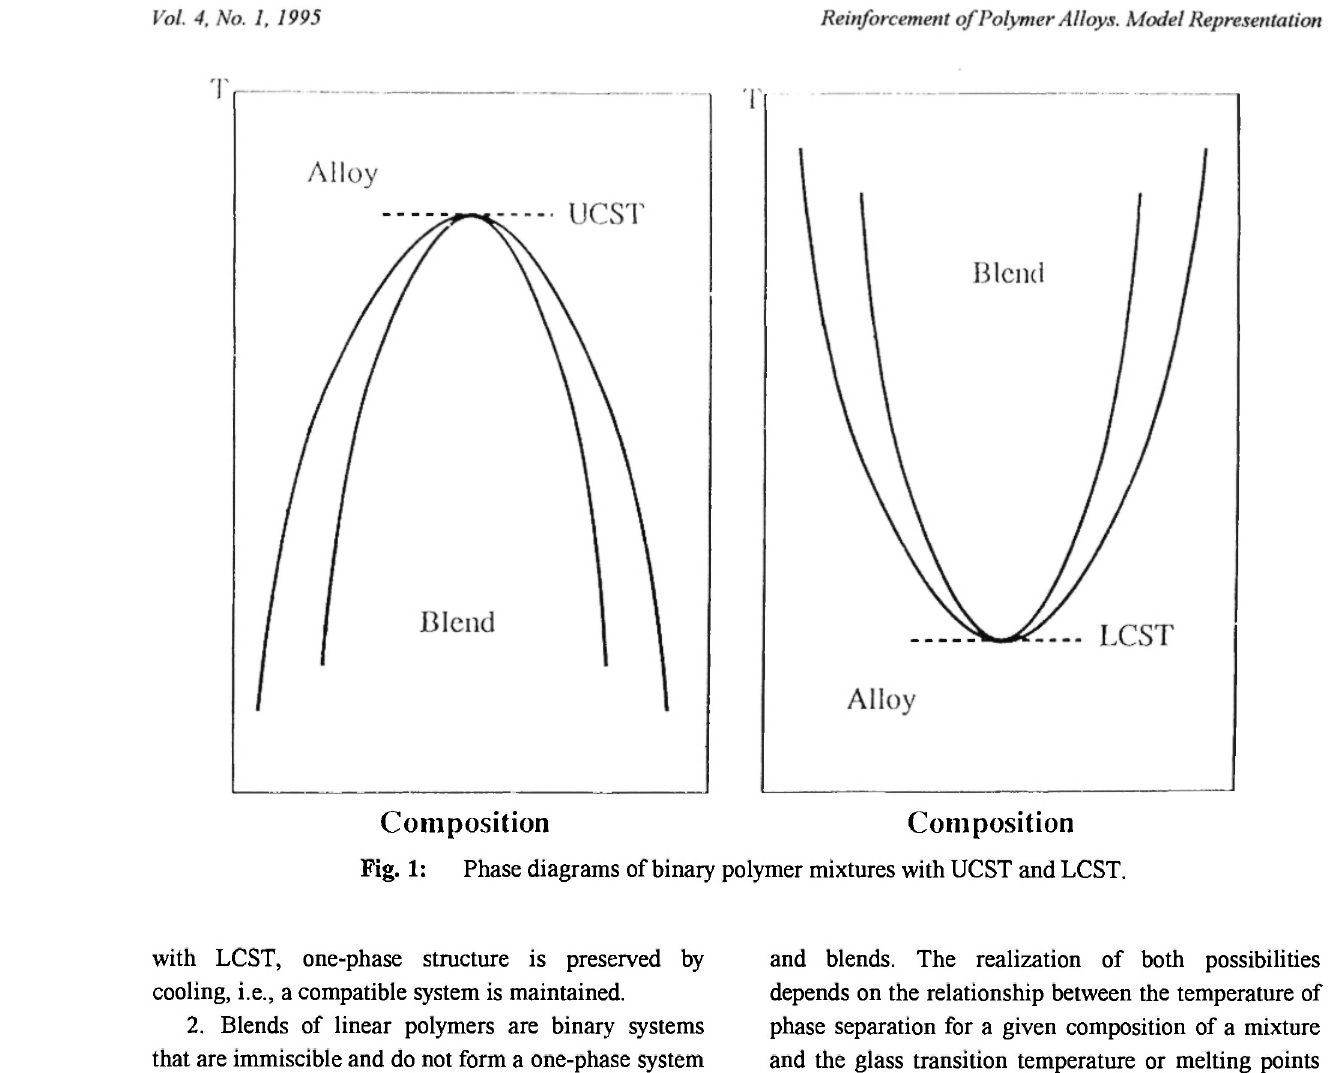
Composition Composition Fig. 1: Phase diagrams of binary polymer mixtures with UCST and